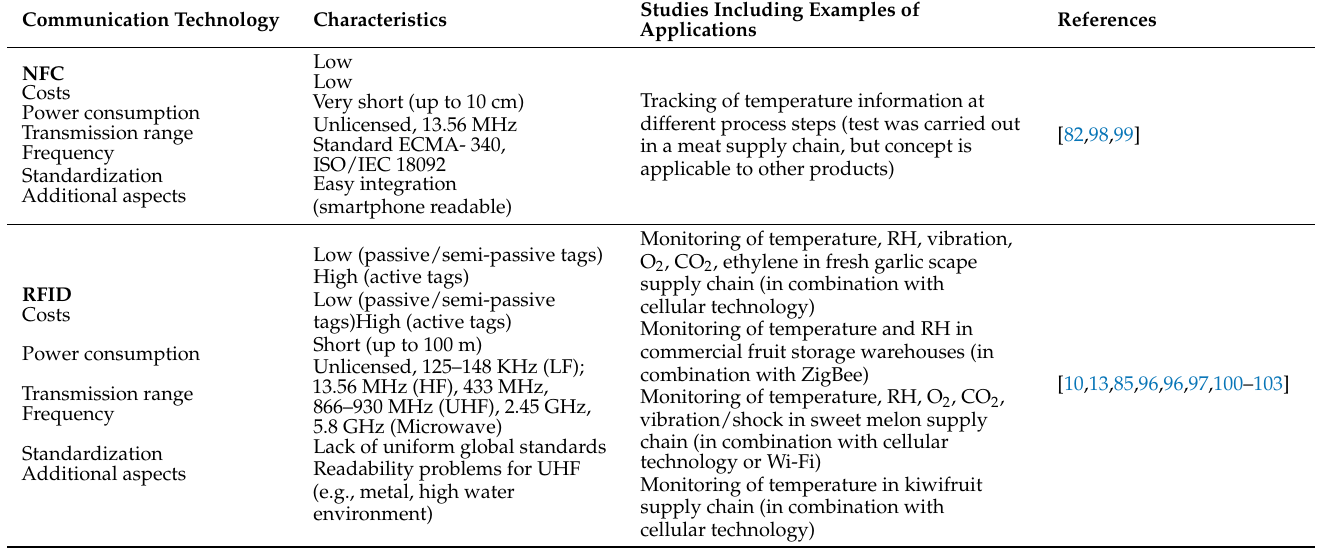
Table 2. Overview of advantages, disadvantages and example applications of wireless communication technologies in the context of parameter monitoring in fresh fruit and vegetable supply